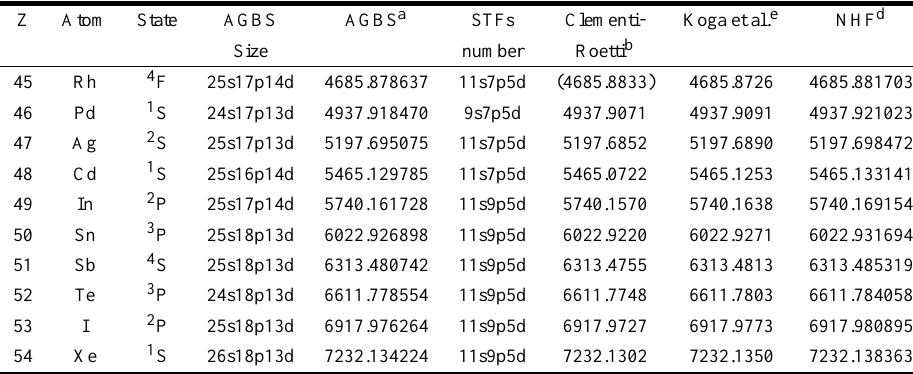
a HF total energies obtained by using our adapted Gaussian basis sets (AGBSs). b HF total energies obtained by using fully-optimized STFs basis sets (Clementi and Roetti 1974). c HF total energies obtained by using fully-optimized STFs basis sets (Koga et al. 1993). d Numerical HF (NHF) total energies for Li to Xe obtained by Bunge et al.